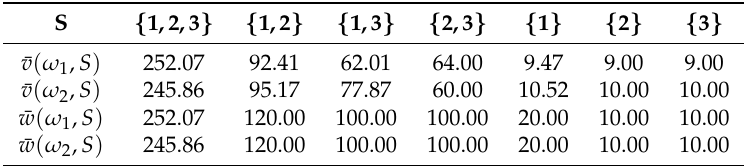
Table 2. Values of characteristic function ¯ v and approximated characteristic function ¯ w for stochastic game starting from states ω 1 and ω 2 .